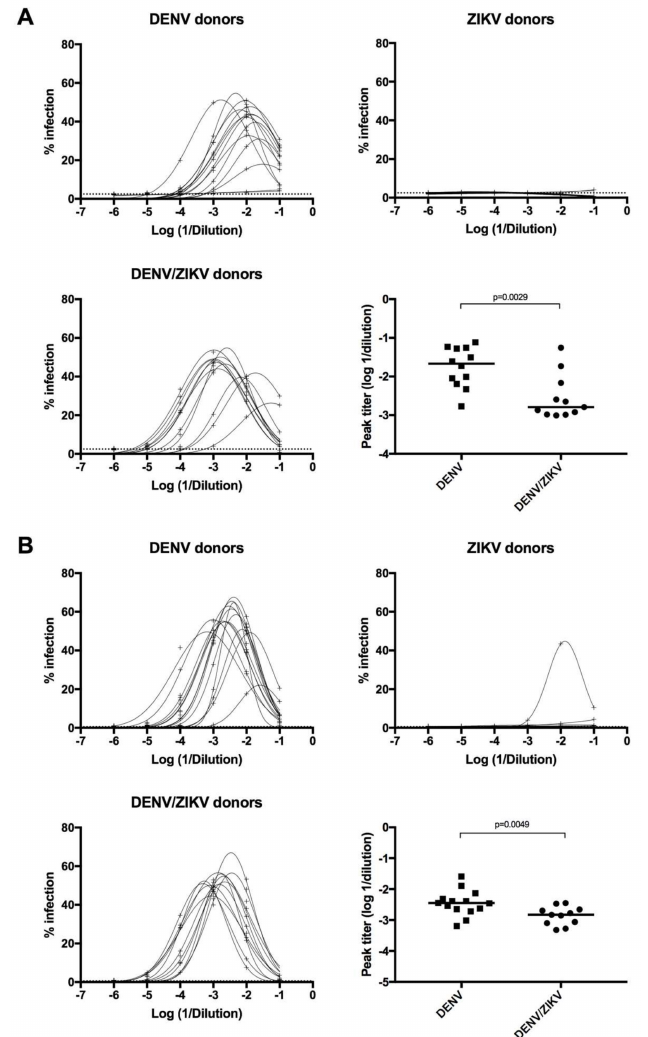
Figure 4. Analysis of Antibody-Dependent Enhancement (ADE) activity of plasma samples on ZIKV and DENV4 infection. ( A ) Detection of ADE activity on ZIKV infection from plasma samples of DENV-immune ZIKV-naïve (higher-left panel), ZIKV-immune DENV-naïve (higher-right panel), and DENV/ZIKV-immune (lower-left panel) donors. Comparison of the peak enhancement titer of antibodies from DENV-immune ZIKV-naïve and DENV/ZIKV-immune donors (lower-right panel). Each dot represents one donor; ( B ) detection of ADE activity on DENV4 infection from plasma samples of DENV-immune ZIKV-naïve (higher-left panel), ZIKV-immune DENV-naïve (higher-right panel), and DENV/ZIKV-immune (lower-left panel) donors. Infectivity curves for each donor are shown. The p values were calculated using the nonparametric two-tailed Mann–Whitney test. The dotted line represents the ELISA cut-off